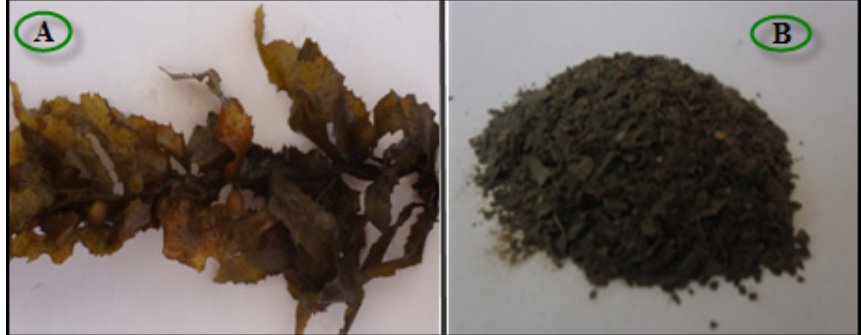
Figure 9. Brown seaweed ( Sargassum muticum ) ( A ), Brown seaweed ( Sargassum muticum ) powder ( B